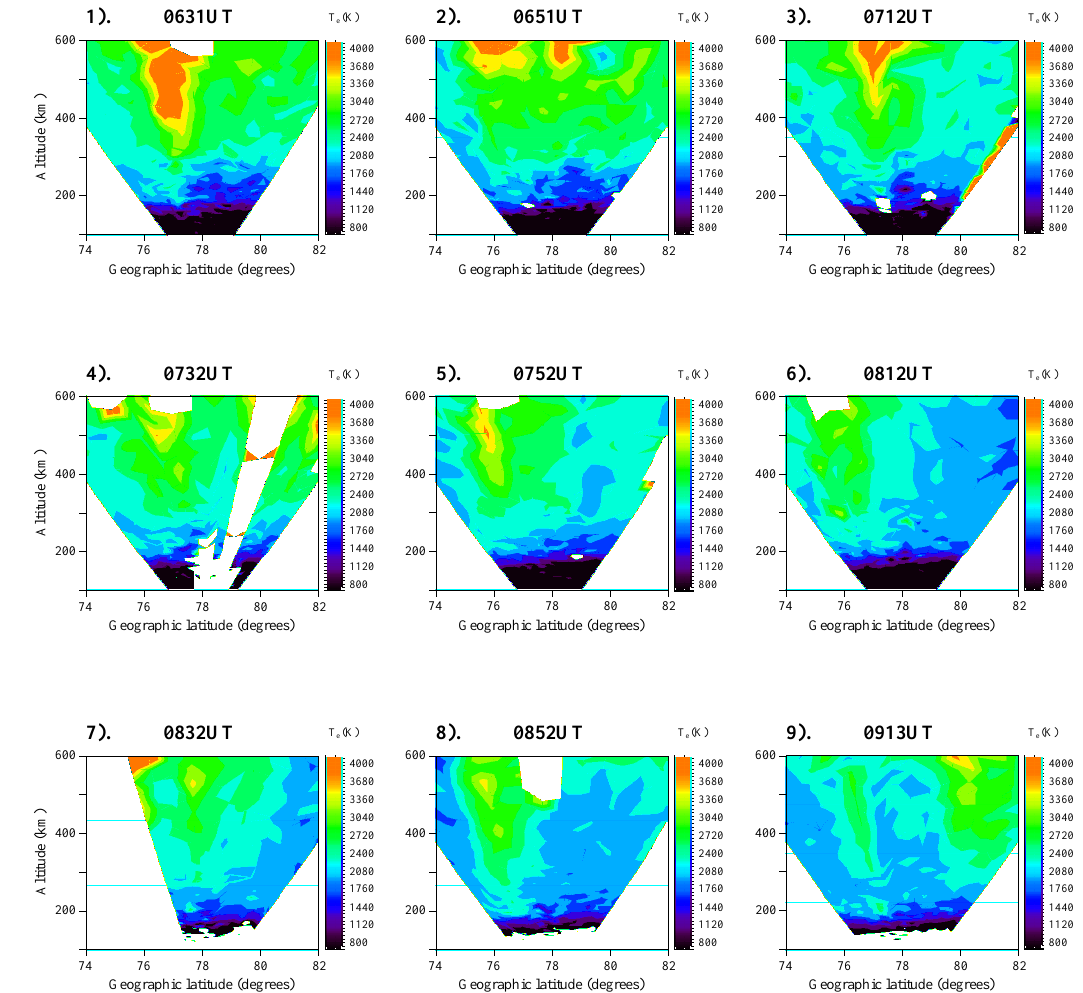
Fig. 3. Electron temperatures measured by the ESR corresponding to the electron densities presented in Fig. 2.